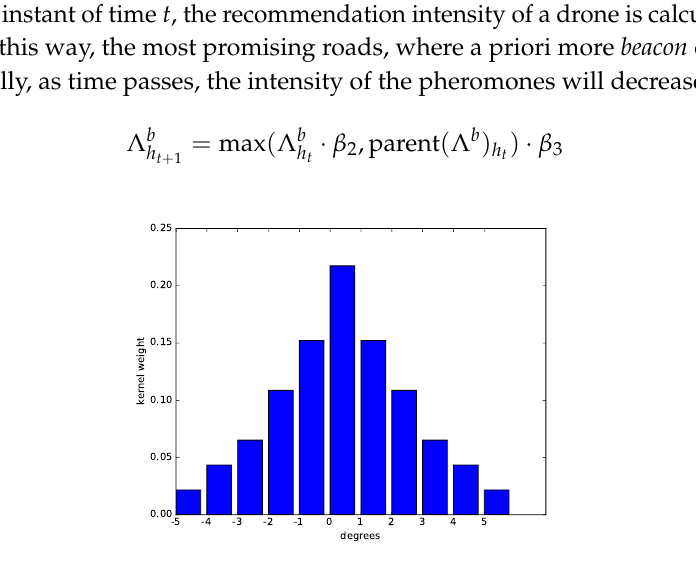
Figure 6. Discrete kernel P ( Λ K ) used for the convolution process of the distribution of beacon